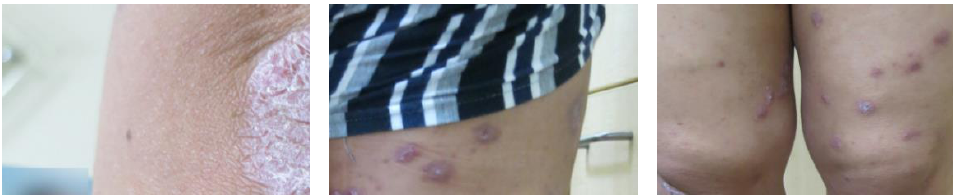
Figure 1. Examples of unconstrained psoriasis images.